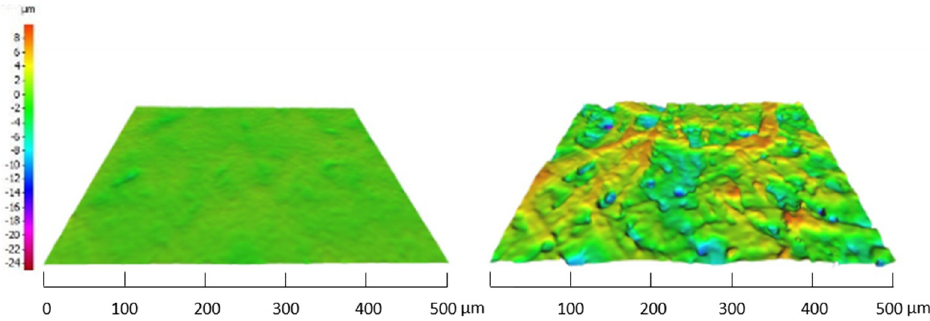
Figure 5. 3D-visualisation of the surface topography of two different paper types. The left image shows a smooth paper sample (Algro Baress) (Ra = 0.29 µm), with relatively low peak-to-peak value (Rz = 5.02 µm). The right image shows a sample (Schutpaper–Acryl/Latex impregnated) with a higher mean surface roughness (Ra = 2.16 µm) and higher peak-to-peak value (Rz = 22.16 µm). The Ra values are in the same range as the DektakXT Stylus Profiler measurements.